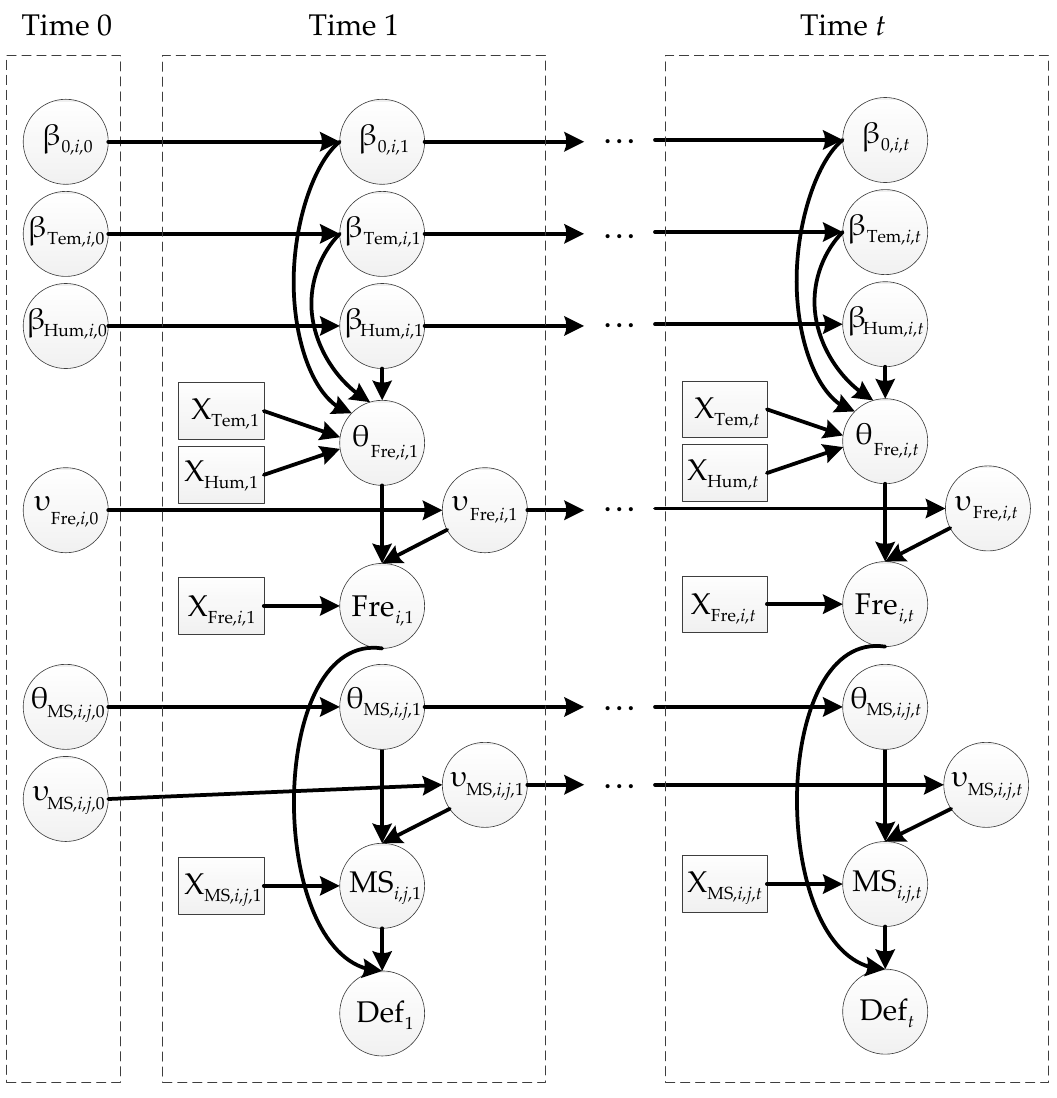
Figure 3. DBN for bridge deflection analysis.